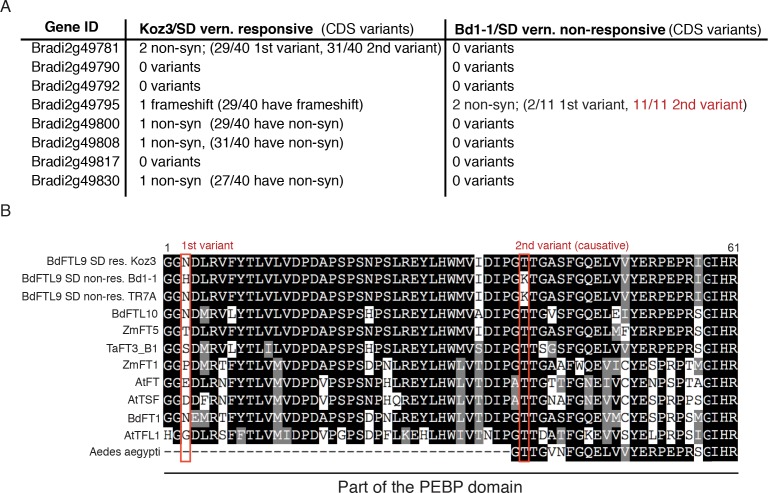
Coding variant summary within the SD vernalization mapped interval between SD vernalization responsive and non-responsive accessions.(A) List of non-synonymous variants (non-syn) or frameshifts that occur in the coding (CDS) region of all annotated genes within the 53.7 kb mapped interval between Koz3 and Bd1-1 and the remaining 49 B.distachyon accessions that have been sequenced (Gordon et al., 2017). In parentheses is the prevalence of that variant across the 40 SD responsive accessions or the 11 SD non-responsive accessions. For a complete list of all variants (intronic, UTR, and intergenic) in the genes within the mapped interval see Data S2. The putative causative variant is in red. Variants within the full genomic sequence of FTL9 were confirmed in all 51 sequenced accessions by Sanger sequencing. (B) Alignment of part of the phosphatidylethanolamine-binding domain in FT-like genes including the ligand-binding motif. The red boxes denote the two non-synonymous variants present in Bd1-1 not found in SD vernalization responsive accessions such as Koz3. The N to H change (1 st variant) is not found across all SD non-responsive accessions and the amino acids at that position are highly variable across FT-like genes. In contrast, the T to K change (2nd variant, causative) in Bd1-1 is present in all SD non-responsive accessions and is in an amino acid that is highly conserved in other PEBP containing genes spanning plants and animals (Aedes aeygypti, a mosquito species, shown as an animal example). Bd = Brachypodium distachyon, Zm = Zea mays, Ta = Triticum aestivum, At = Arabidopsis thaliana.